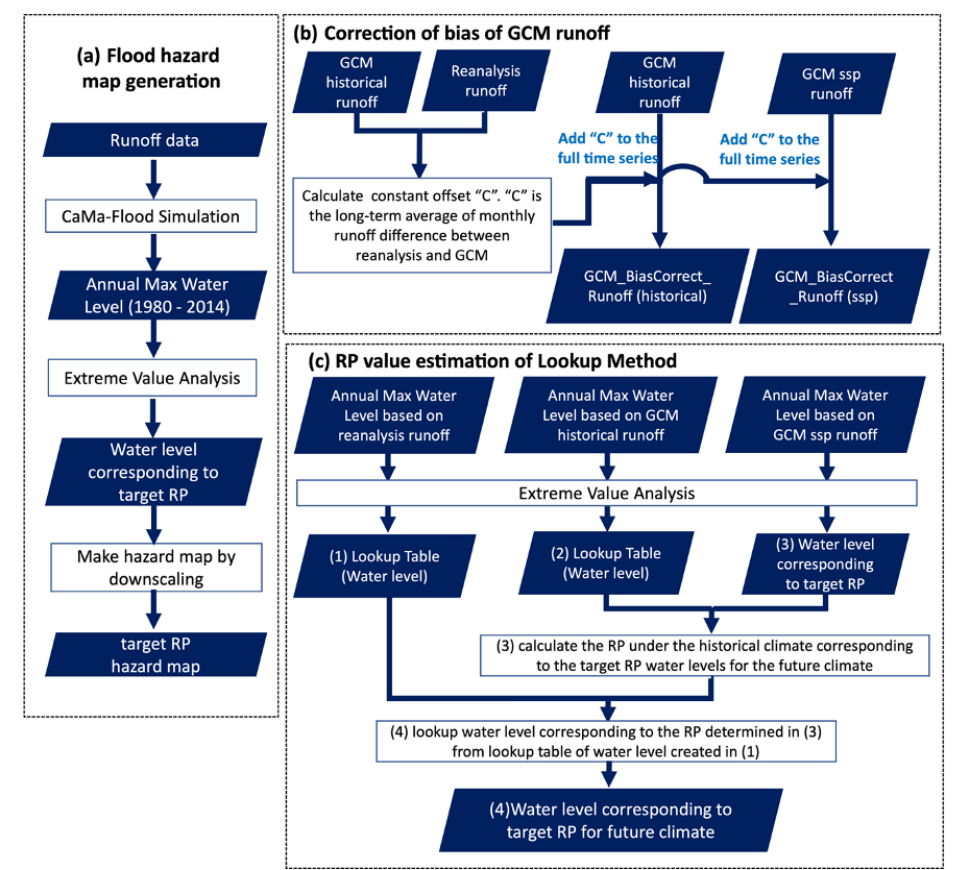
Figure 1. Simplified schematic diagrams of (a) flood-hazard map generation, (b) correction of bias of GCM runoff, and (c) RP value estimation via the lookup